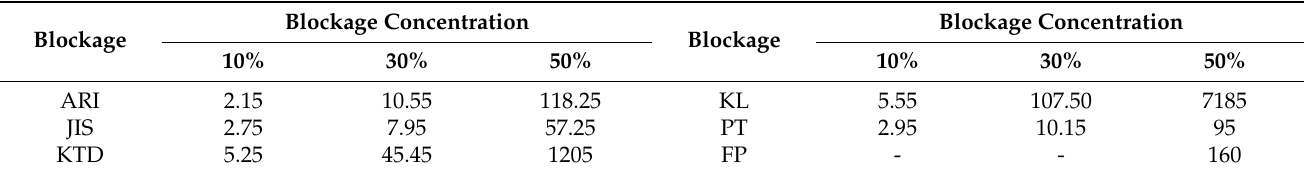
Table 16. Viscosity result for each blockage (Unit: mPa · s).